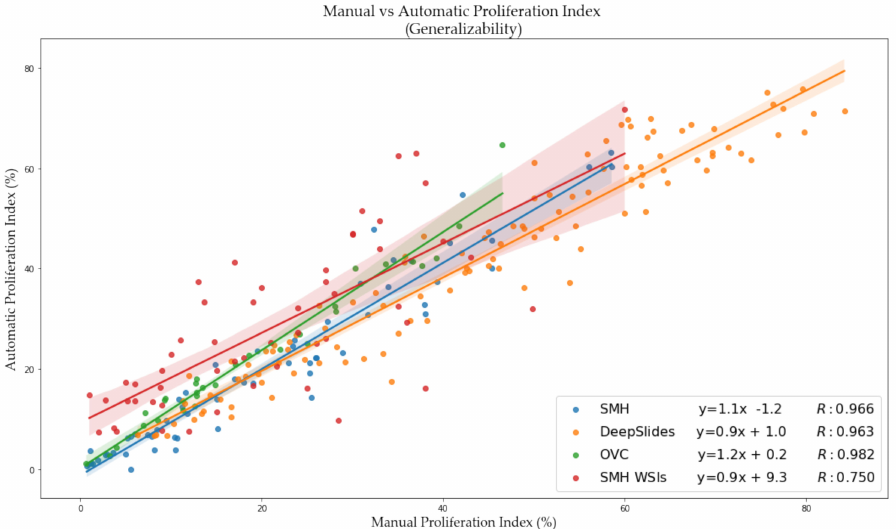
Figure 19. Correlation of automated and manual PI estimates over four, multi-centre datasets with single outlier